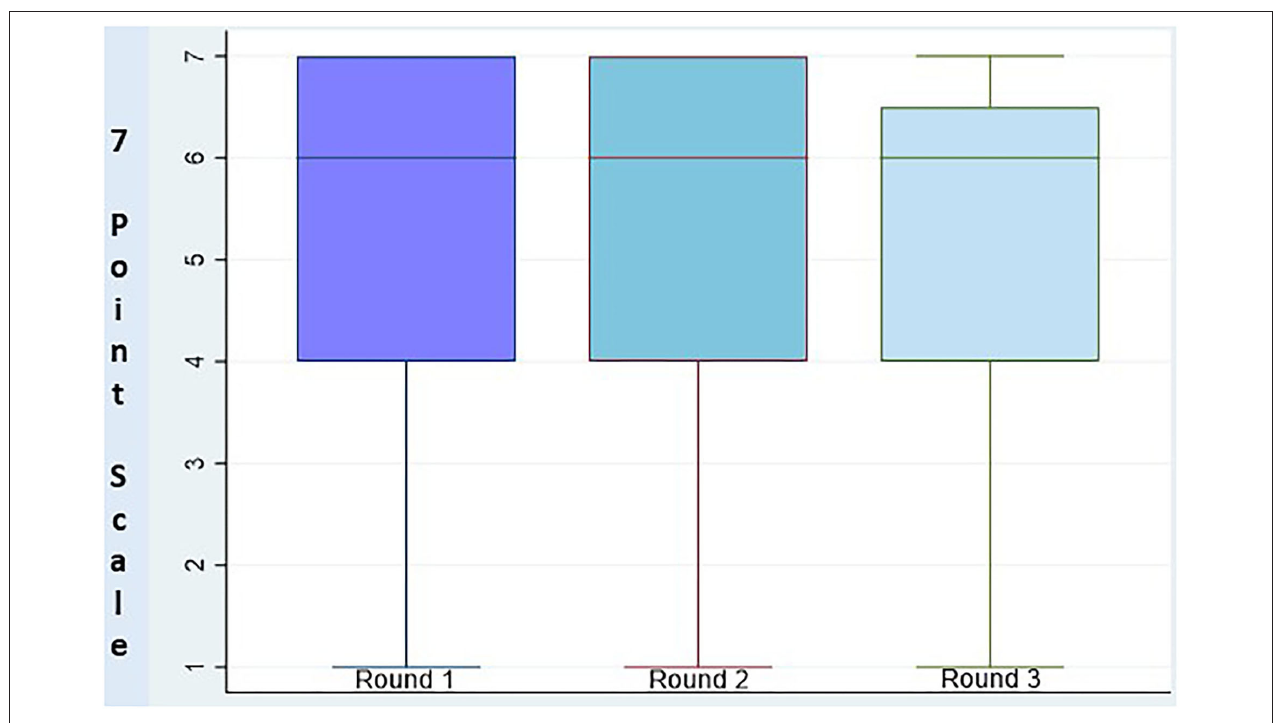
FIGURE 1 | Distribution of responses between rounds.